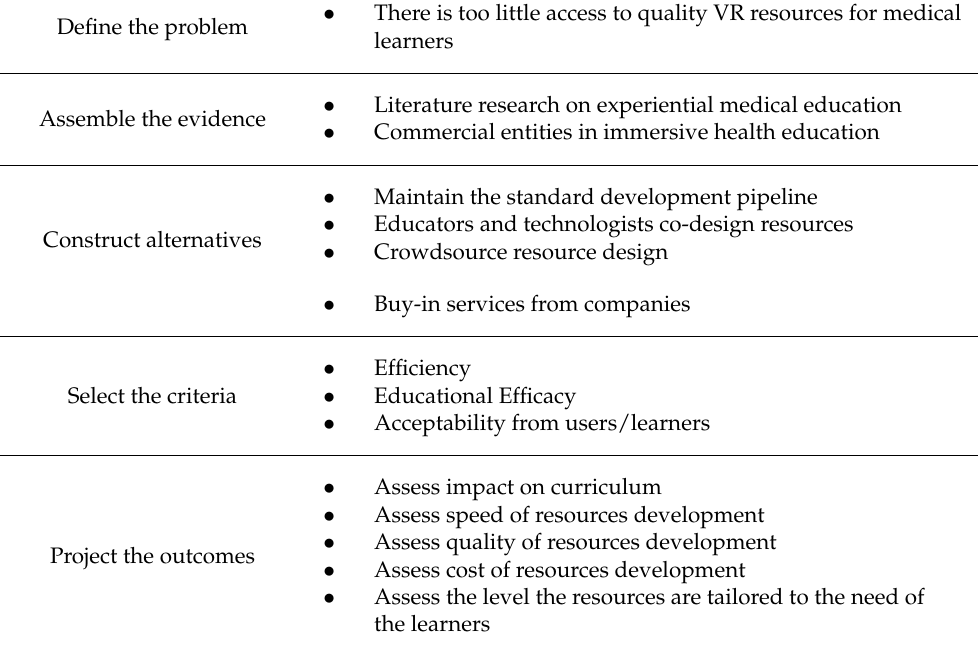
Table 1. Eightfold policy analysis framework for VR educational content creation